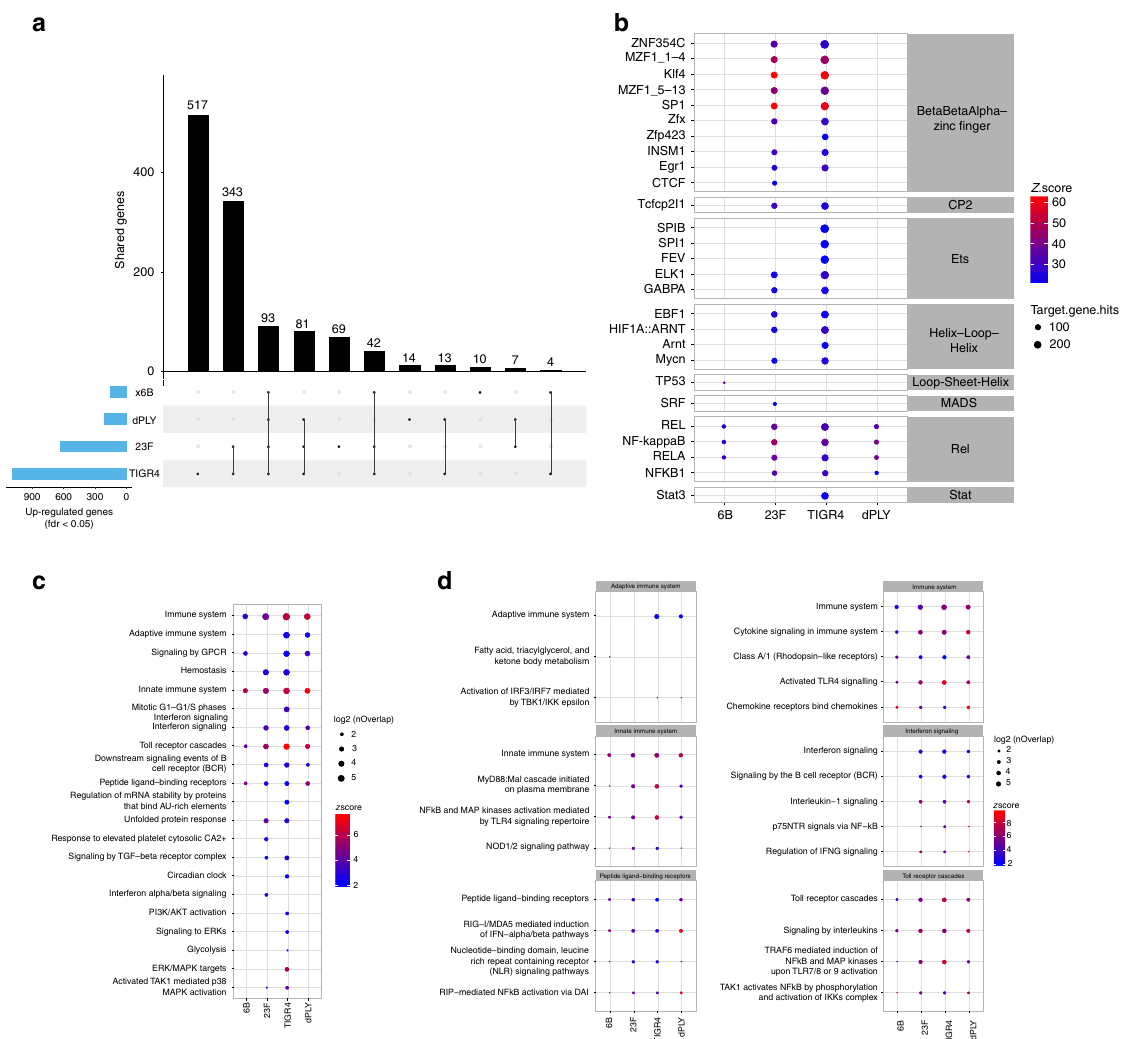
Fig. 6 Transcriptomic responses to S. pneumoniae in vitro are in fl uenced by adhesion and micro-invasion. a The total number of Detroit 562 epithelial genes upregulated following exposure to 6B, 23F, TIGR4 and TIGR4-dPly pneumococci, compared with non-infected samples. N = 3 independent experiments with replicates. Genes with an FDR <0.05 were considered for further analysis. The matrix shows intersections for the four strains, sorted by size. Dark circles in the matrix indicate sets that are part of the intersection. b Bubble heatmap showing the results of transcriptional factor analysis in Opossum for each strain. Transcriptional factors are ordered by family and then sorted by number of genes in the database. The colour represents the log2 z -scores (a continuum from blue (lowest values) to red (highest values)) and the size shows the number of genes annotated to the particular pathway. c Bubble heatmap showing the results of reactome pathway analysis for upregulated genes in each strain compared with non-infected cells. Pathways were clustered in 20 groups using K-means on Jaccard index and the biggest pathway for each group was selected for representative annotation of each cluster. Individual pathways within clusters are shown in Supplementary Fig. 8. The colour represents the log2 z -scores (a continuum from blue (lowest values) and red (highest values)) and the size shows the number of genes annotated to each pathway. d Selected bubble heatmap clusters representing the individual pathways within each cluster from ( c